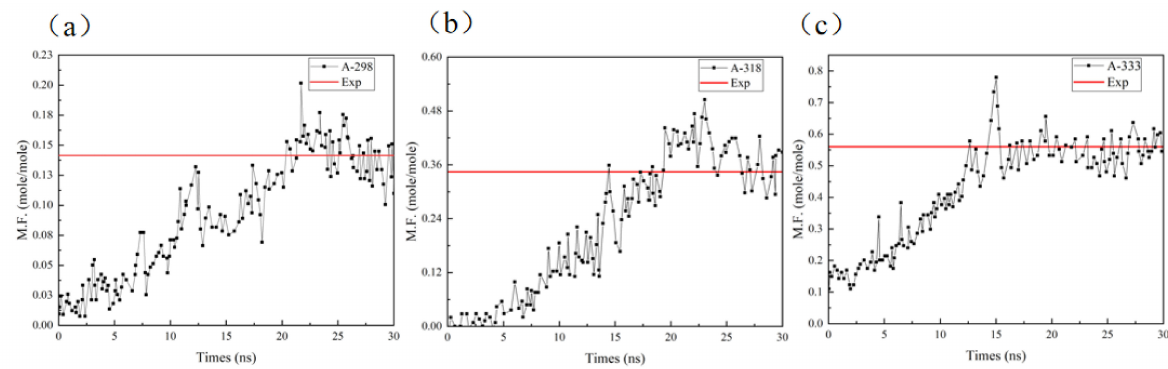
Figure 5. Schematic diagram of M.F. change with time for ( a ) A-298 model, ( b ) A-318 model, ( c ) A- 333 model.